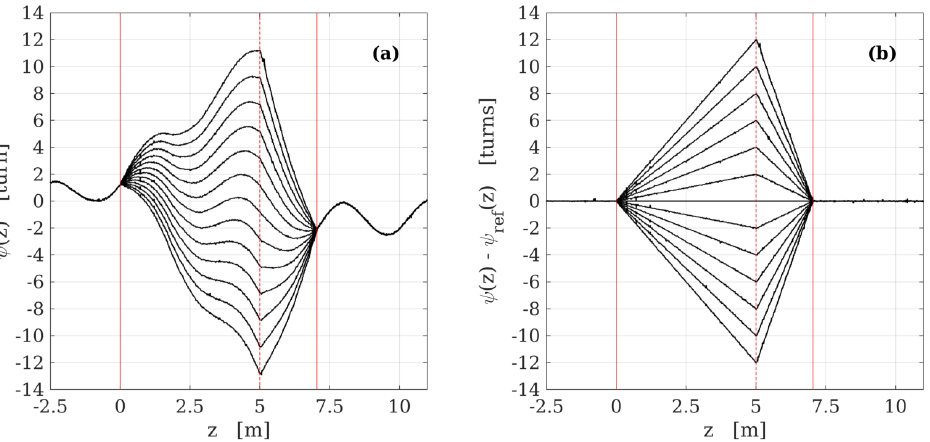
Figure 6. Polarimetric distributed measurement of twist along a single mode fiber for twists ranging from − 12 to 12 turns, applied at the position marked by the dashed vertical line, while the fiber was fixed at positions marked by the solid vertical lines. ( a ) Raw angles of orientation of the linear birefrin- gence vector; the undulatory pattern is due to intrinsic spin-induced rotation of fiber birefringence. ( b ) Orientation variations with respect to the reference measurement; the measurements accurately track the local twist applied to the